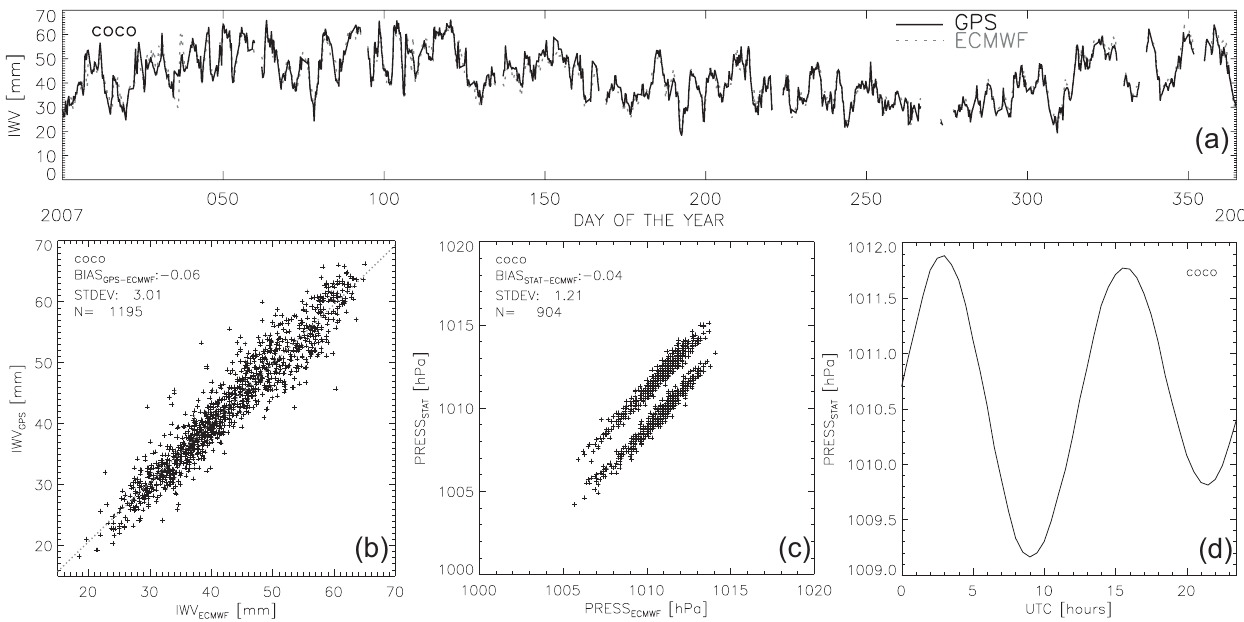
Fig. 2. Results for station Cocos, (a–c) same as Fig. 1. Panel (d) shows ground pressure mean diurnal cycle as derived from ground meteorological